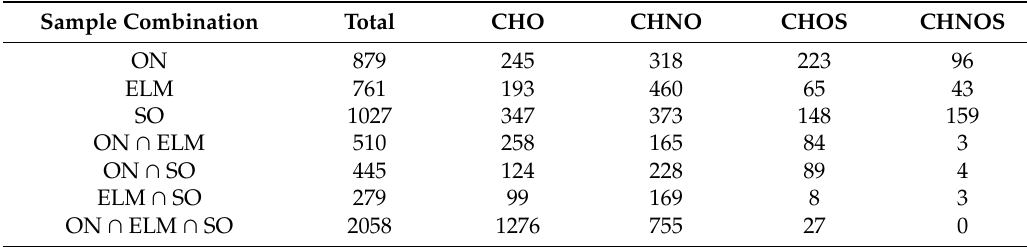
Table 3. Molecular diversity of the solid phase extracted DOM (SPE-DOM) of samples collected from the two hot springs (ON, ELM) and Lake Sonachi